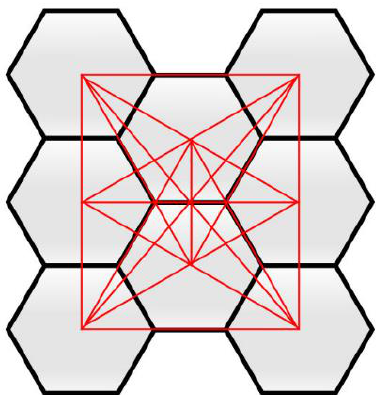
Figure 2. An example of maximum transport provision of territories.